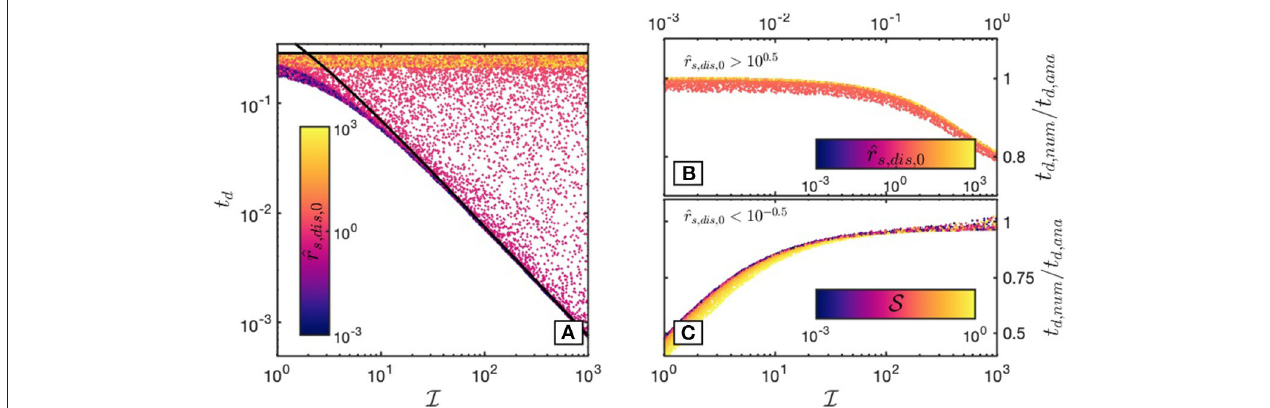
FIGURE 7 | Detachment times t d for a simulation subset with I > 1 and S < 1 (large grain damage, low thermal damage). (A) t d as a function of the grain damage r s , dis ,0 for each simulation (large values indicating that dislocation creep is more dominant during necking). The solid black parameter I . Colors denote the value of ˆ lines denote the analytical predictions for grain damage dominated weakening (given by Equation 57) and damage insensitive necking (Equation 43). (B) Validity of the r s , dis ,0 > 10 1 (dislocation creep controlled necking). Shown is the ratio analytical detachment time prediction for a subset of the simulations shown in (A) with ˆ t d , num / t d , ana between the respective numerically computed detachment time [given by Equation (50)] and the analytical prediction vs. the thermal damage parameter S . Colors denote the value of the thermal damage parameter S for each simulation. (C) Ratio t d , num / t d , ana but for a subset of the simulations shown in (A) with r s , dis ,0 < 10 − 1 (diffusion creep controlled necking) vs. the grain damage parameter I . Here, Equation (57) is appropriate to predict the detachment time. ˆ